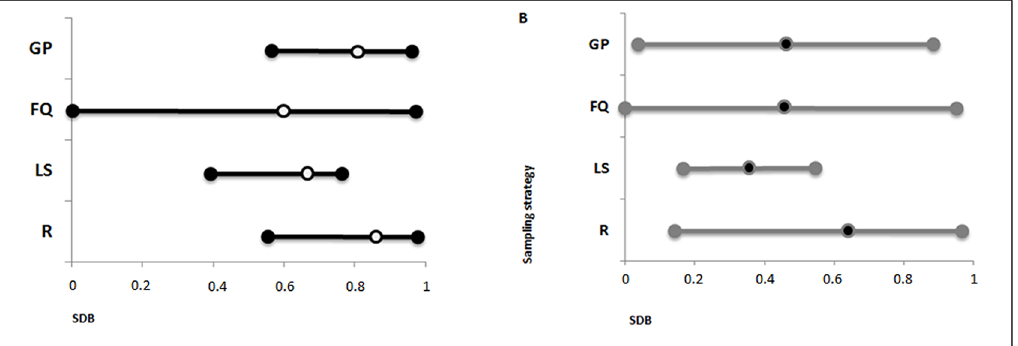
Fig 2. Minimum, maximum and mean values of the sampling-dependent bias (SDB) calculated after sampling by random (R), locally spread (LS), first quartile (FQ) and grandparents (GP) strategies, under the low-kinship (A) and the high-kinship (B) models in the 26 investigated